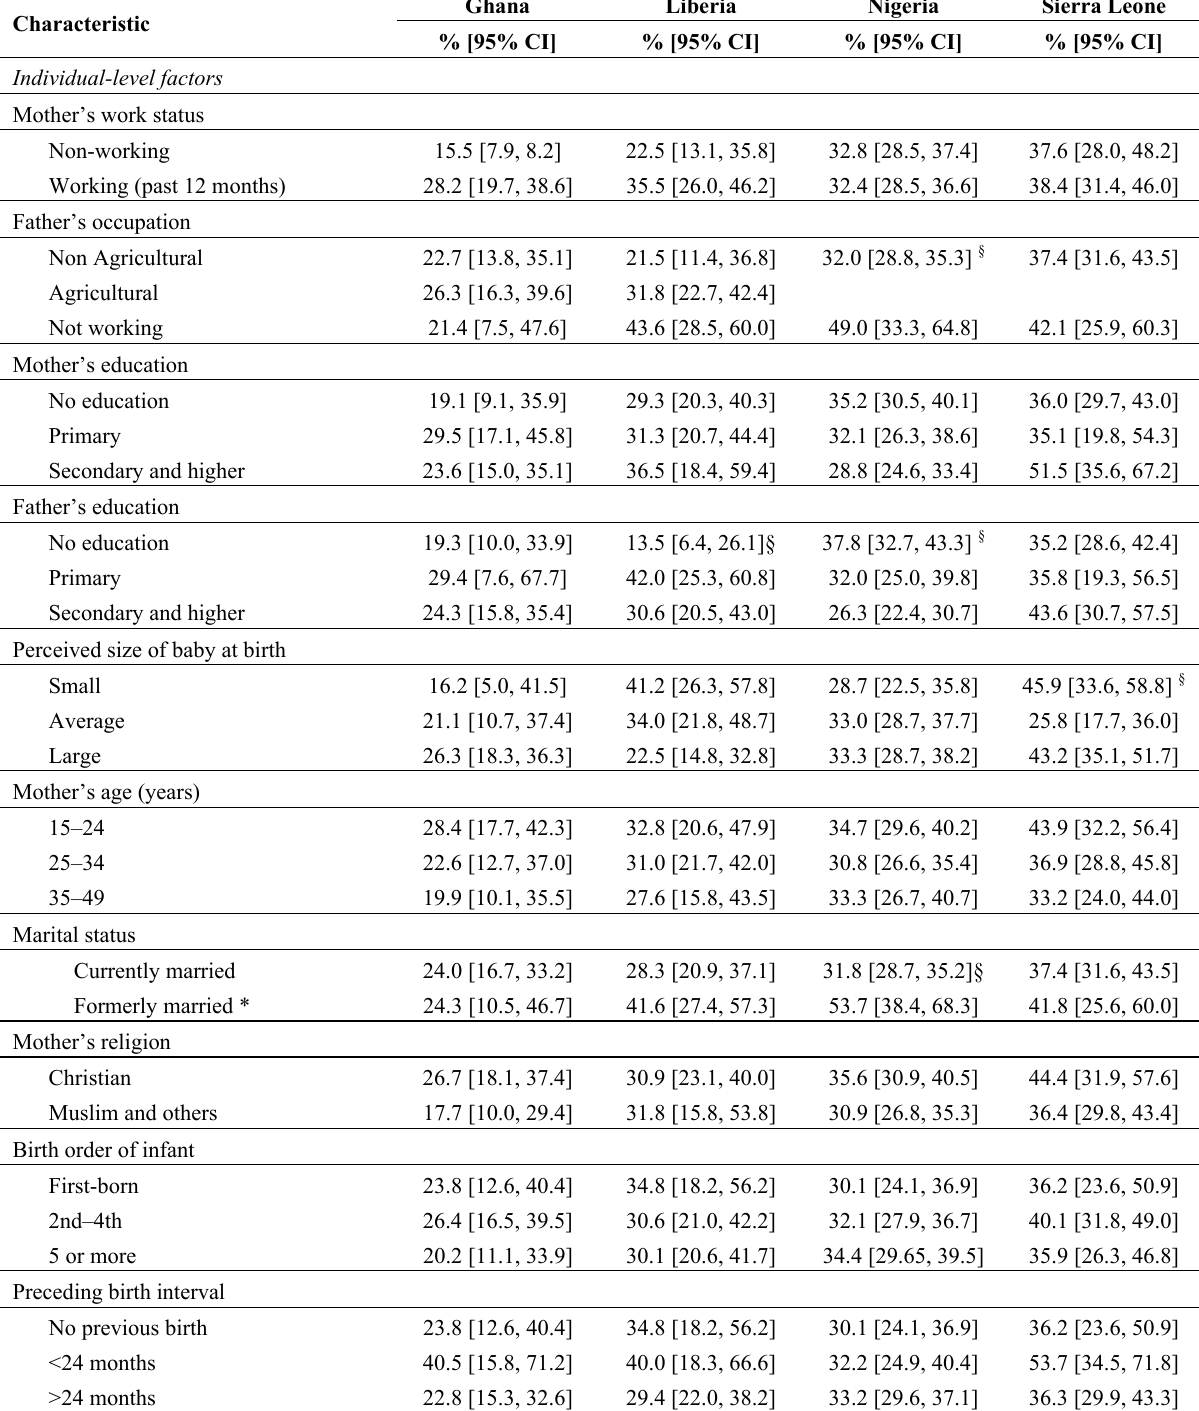
Table 2. Early introduction of solid, semi-solid or soft foods among infants aged 3–5 months by Individual-, Household- and Community-level characteristics in 4 Francophone West African countries,